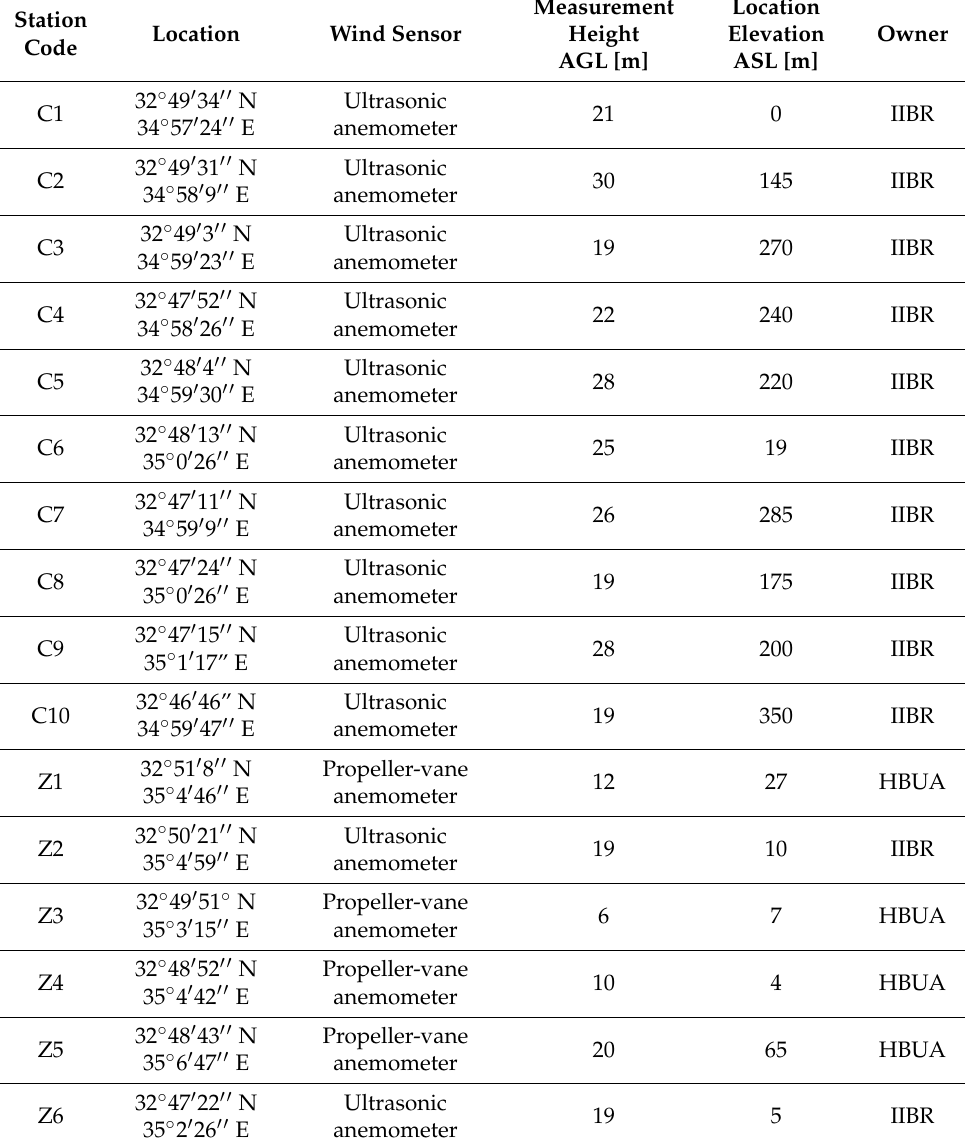
Table 1. The stations analysed in this study. Stations’ code with a C prefix are located on Mount Carmel, and those whose code begins with Z are located in the Zevulun valley. Stations owned by IIBR were installed during a one-year campaign during 2014–2015. Stations owned by HBUA are a part of the ongoing monitoring network of Haifa metropolitan area (http://www.envihaifa.net (accessed on 1 February 2021)).